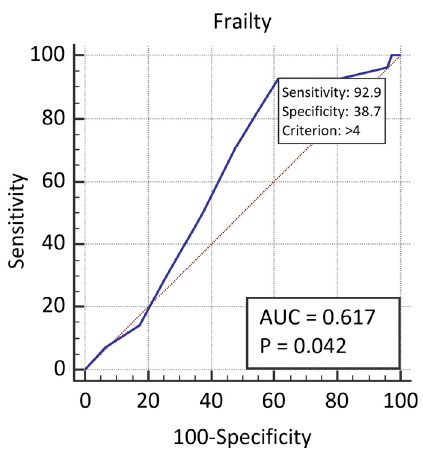
Figure 1. The ROC curves for the prediction of an electric shock of an ICD by frailty.